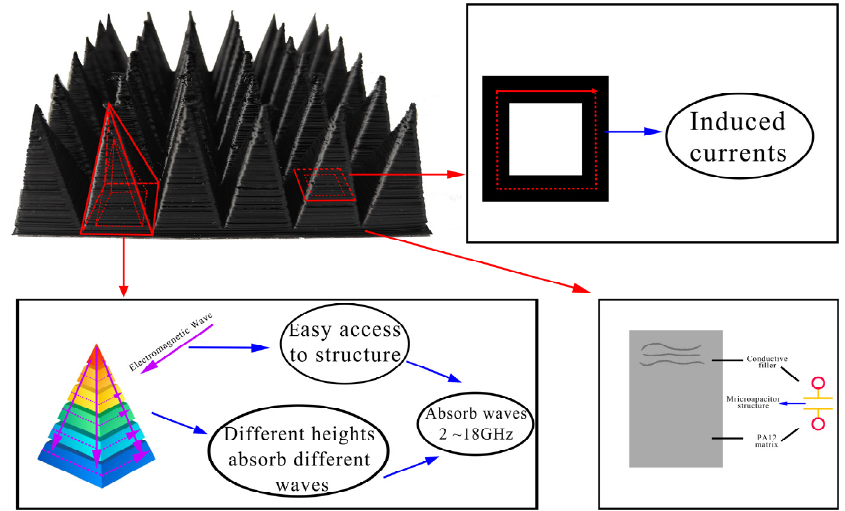
Figure 19. The absorbing principle of the pyramid absorber. Figure 18. RL spectra of the printed pyramid absorber and simulating pyramid model.